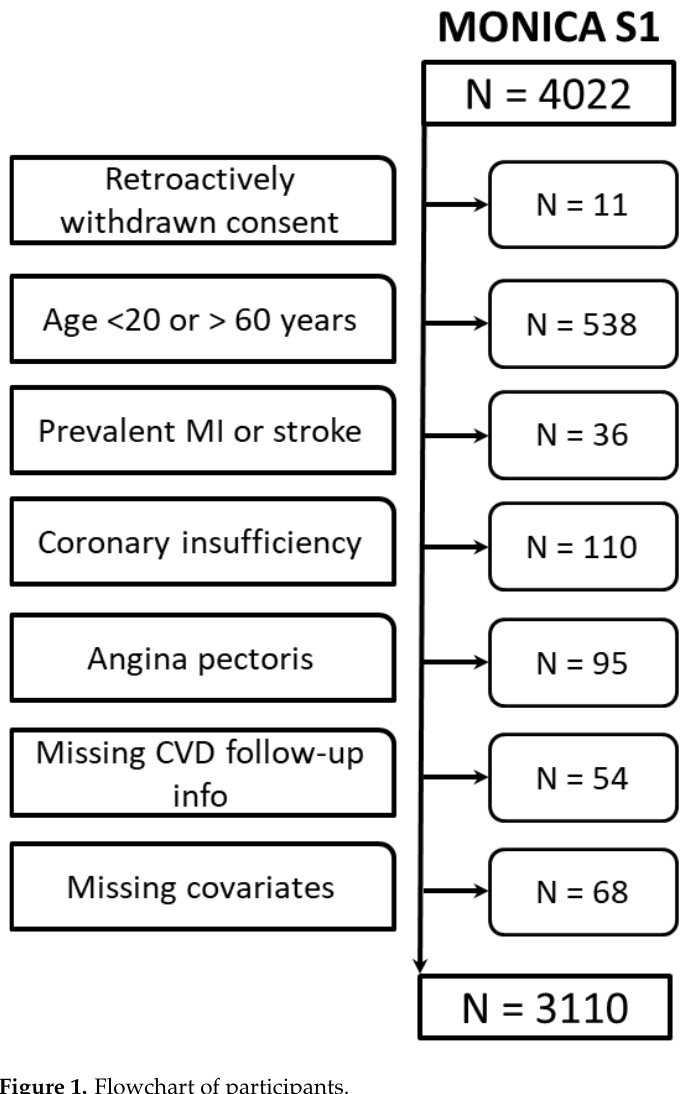
Figure 1. Flowchart of participants.